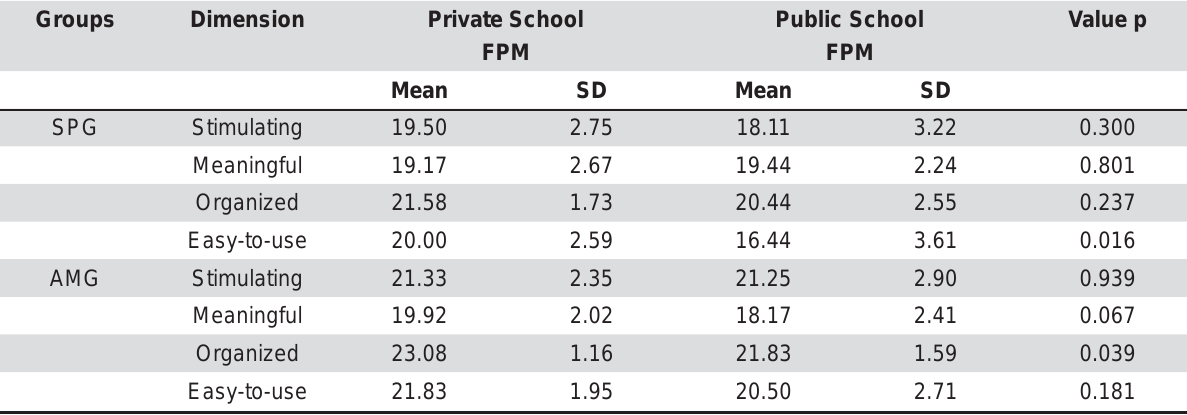
SPG=São Paulo Group; AMG=Amazonas Group; SD=Standard Deviation